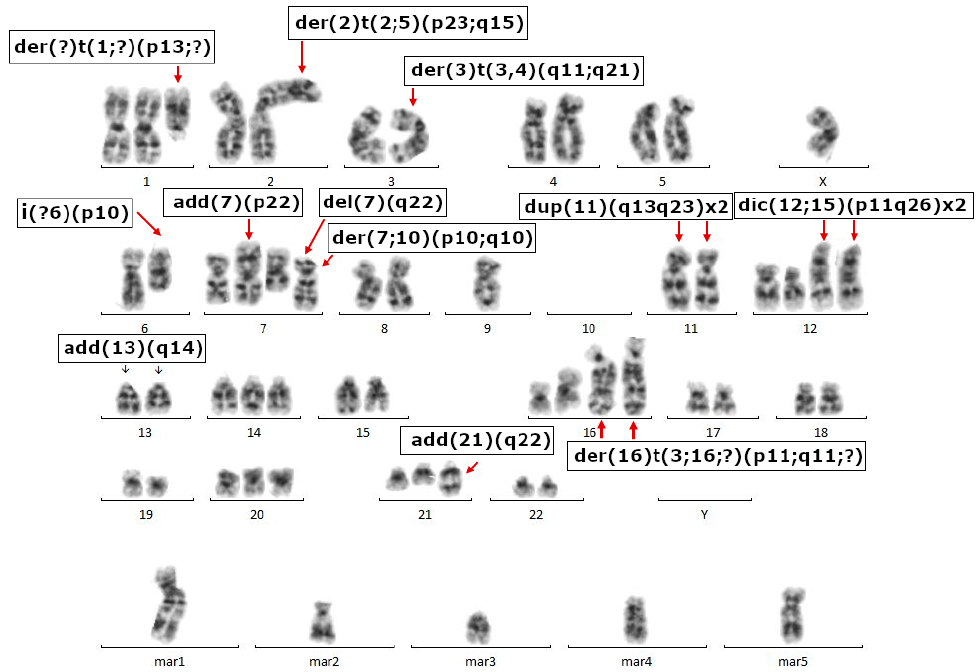
Figure 6. An example of the OVPA8 karyotype with the main chromosomal aberrations indicated.